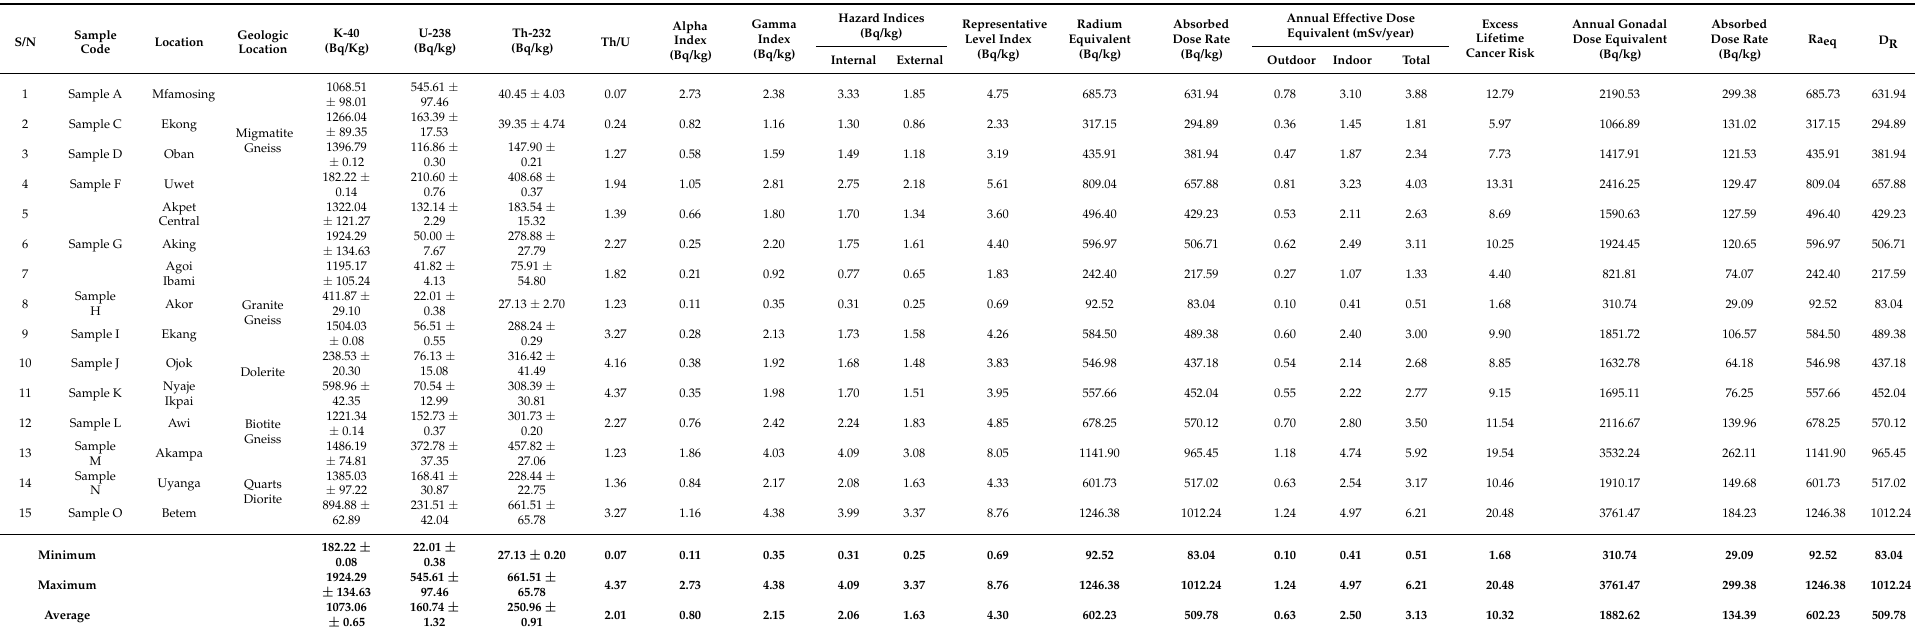
Table 1. Activity concentration of the radionuclides and radiological